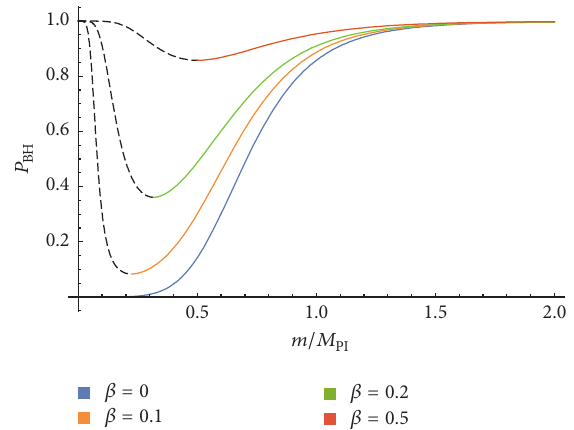
Figure 3: Analytic approximation of the probability 𝑃 BH (𝑚) for a particle to be a black hole versus mass of the particle for increasing values of the free parameter 𝛽 . Dashed lines correspond to values where 𝑚 < √𝛽/2𝑀 Pl .